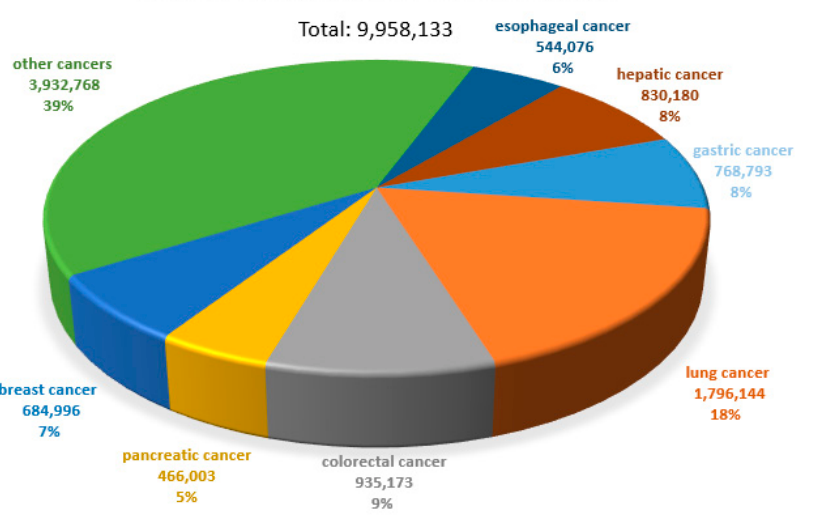
Figure 1. Estimated number of deaths due to all cancers worldwide. Both sexes, all ages. WHO data (2020), URL address [4], modified.